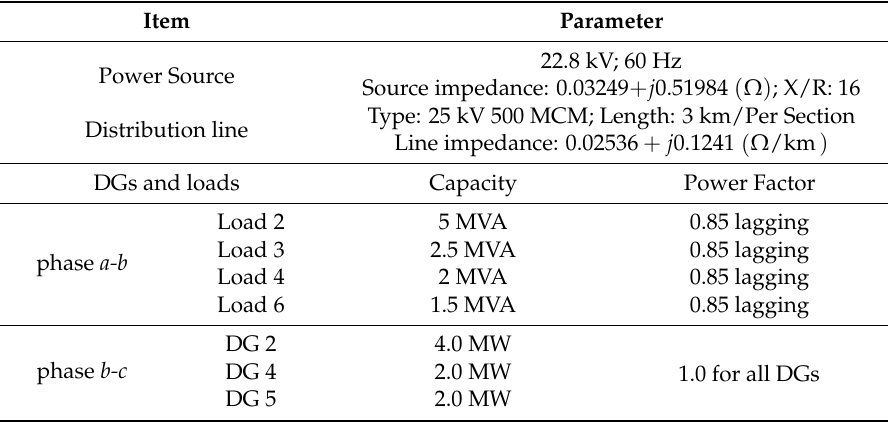
Table 1. Test system parameters.